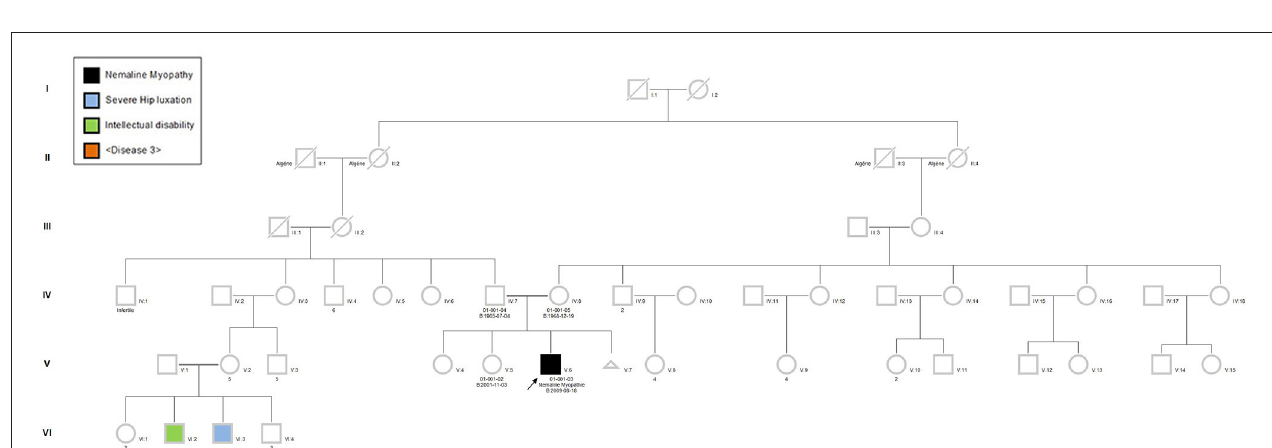
FIGURE 2 | Pedigree of the patient’s family. The proband (black square), his sister, father, and mother were recruited in the project. Due to the consanguinity, autosomal recessive type of inheritance was suspected. Pedigree symbols. Circle, female; square, male; black filled, affected; unfilled, non-affected.